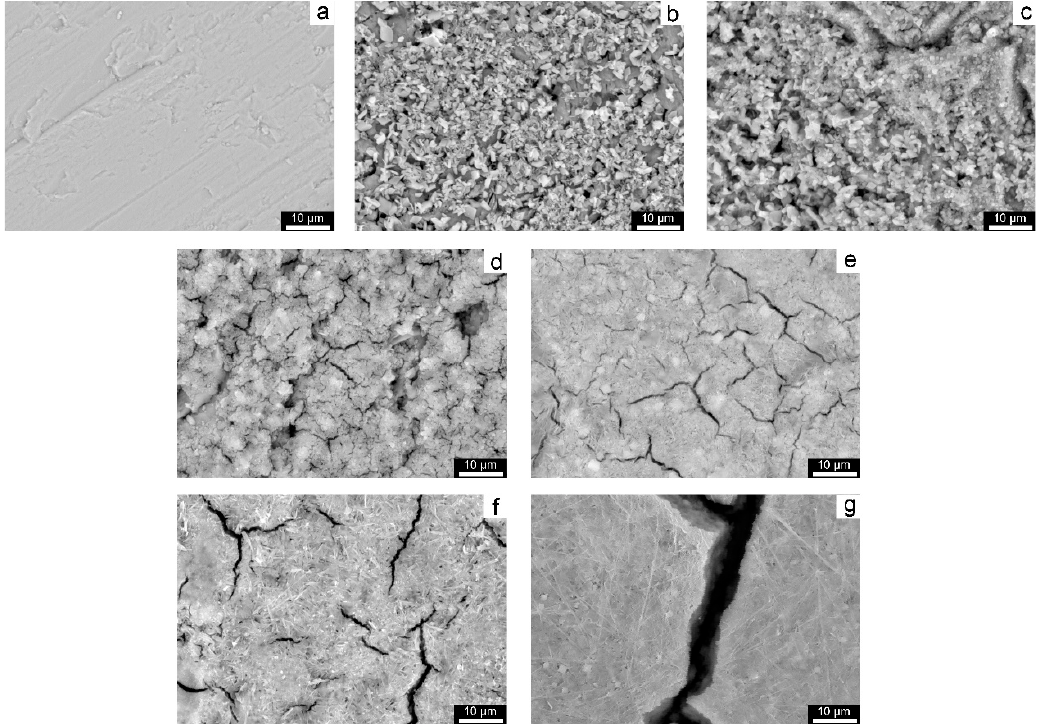
Figure 4. SEM image of untreated and treated samples: ( a ) UT, ( b ) AO, ( c ) 0.02 mol/L CA, ( d ) 0.04 mol/L CA, ( e ) 0.06 mol/L CA, ( f ) 0.08 mol/L CA, ( g ) 0.10 mol/L CA.